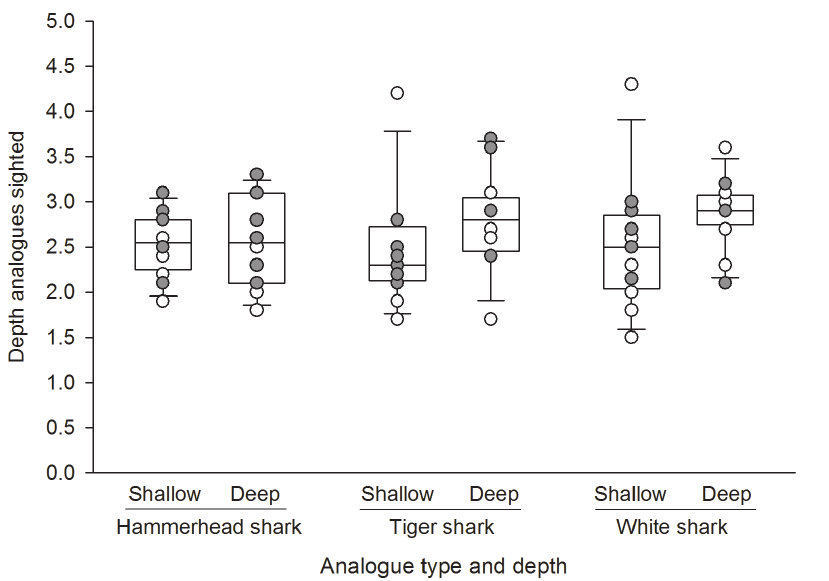
Figure 1. Depths at which shark analogues were sighted by fixed-wing and helicopter observers maintaining their position at 500 ft ( , 150 m) around a known position. Overlaid are individual data points from each aircraft; open circles represent fixed-wing sightings, closed circles represent helicopter sightings.